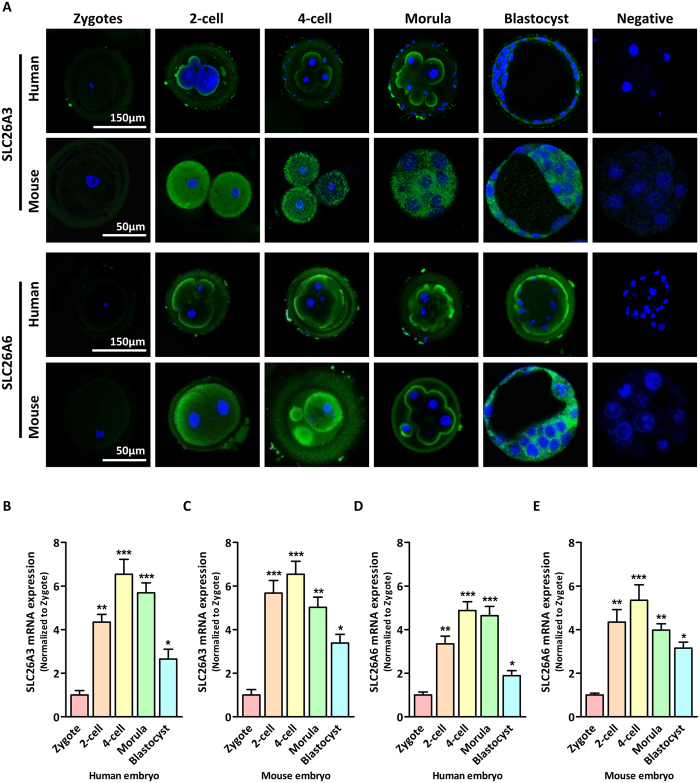
Expression of SLC26A3 and SLC26A6 in preimplantation embryos.(A) Immunofluorescent results showing the localization of SLC26A3 (upper panel, green) and SLC26A6 (lower panel, green) protein in different stages of human and mouse preimplantation embryos. Nuclei were counterstained with DAPI (blue). (B–E) Quantitative real-time PCR results showing the levels of SLC26A3 (B,D) and SLC26A6 (C,E) mRNA expression during human (B,C) and mouse (D,E) preimplantation embryo development. * indicates P < 0.05, ** indicates P < 0.01, *** indicates P < 0.001 (by one-way ANOVA, ~100 embryos in each experiment, n = 4).